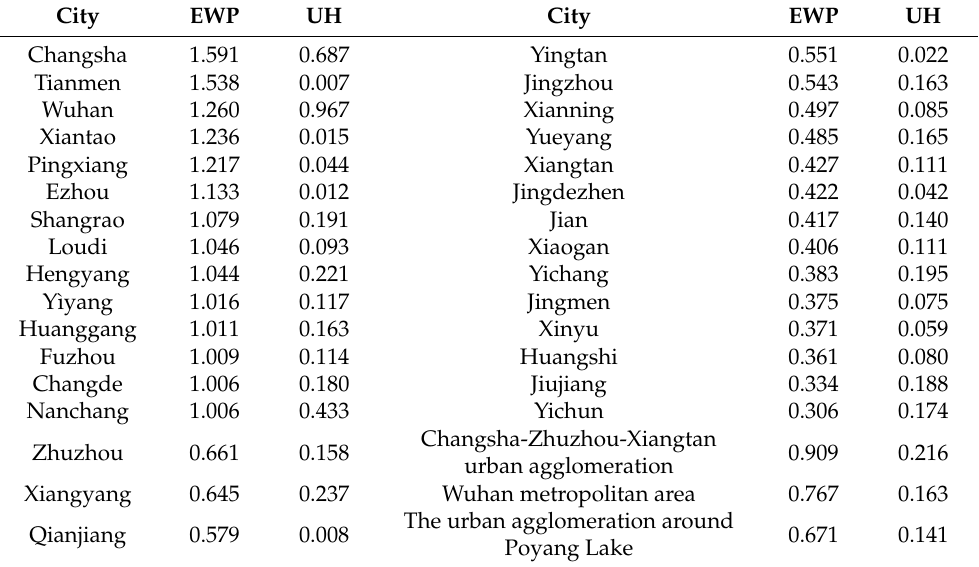
Table 3. The EWPs and UHs of urban agglomeration in the middle reaches of the Yangtze River (MRYRUA) in